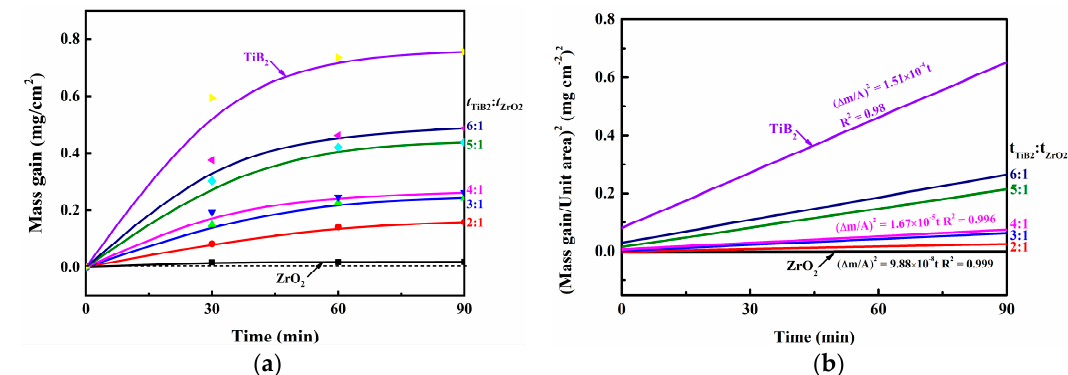
Figure 6. ( a ) The thermogravimetric curves and ( b ) the plots of ( ∆ m / A ) 2 versus time of the TiB 2 and ZrO 2 monolayers and the TiB 2 / ZrO 2 multilayers during oxidation. Table 1. The calculated K , R 2 and E a (activation energy) values of TiB 2 , ZrO 2 monolayers and TiB 2 /ZrO 2 multilayers tested at 600 °C, respectively.